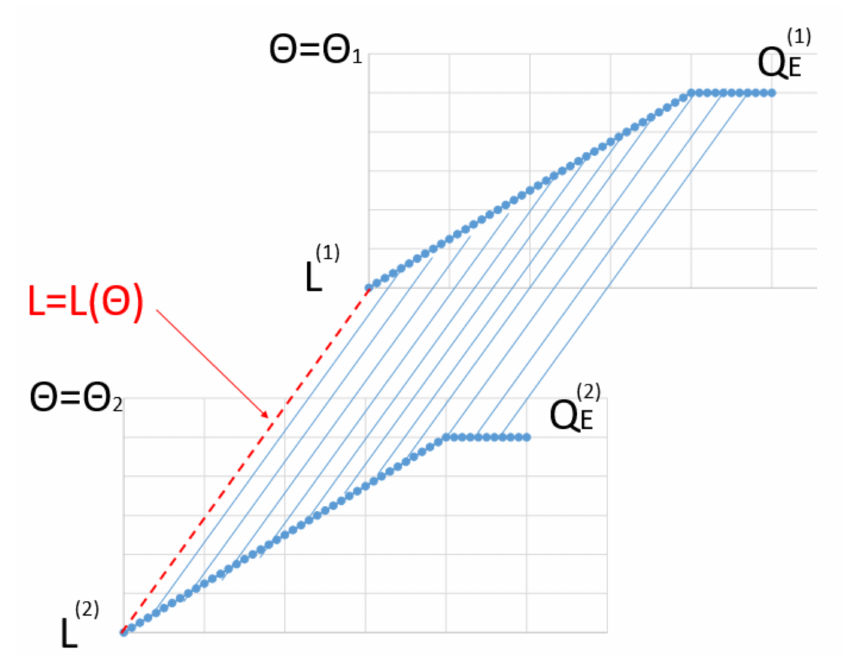
Figure 2. Resilience in the domain (t, Θ ), linear recovery